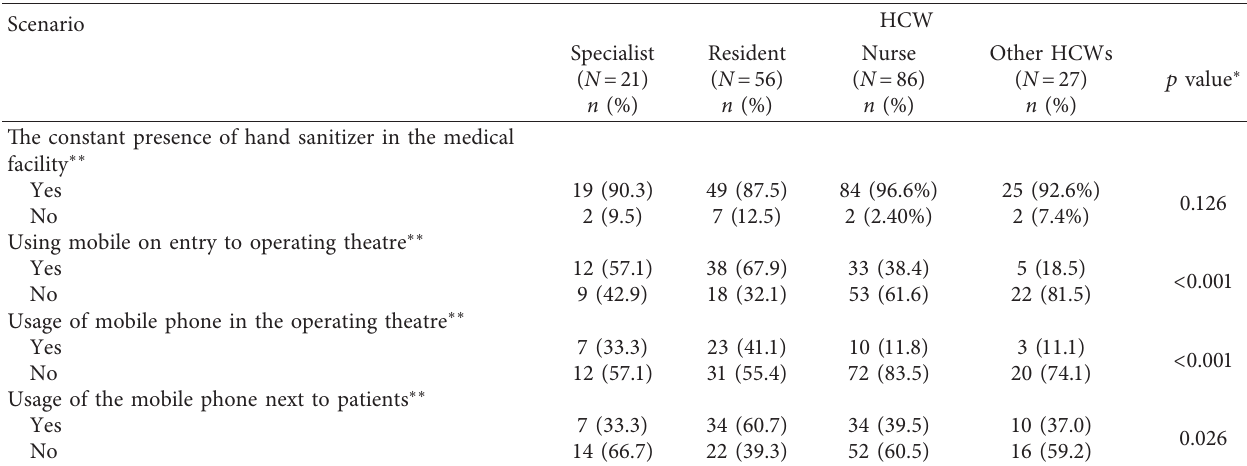
Table 2: The use of MPs by HCWs in unique characteristic scenarios.